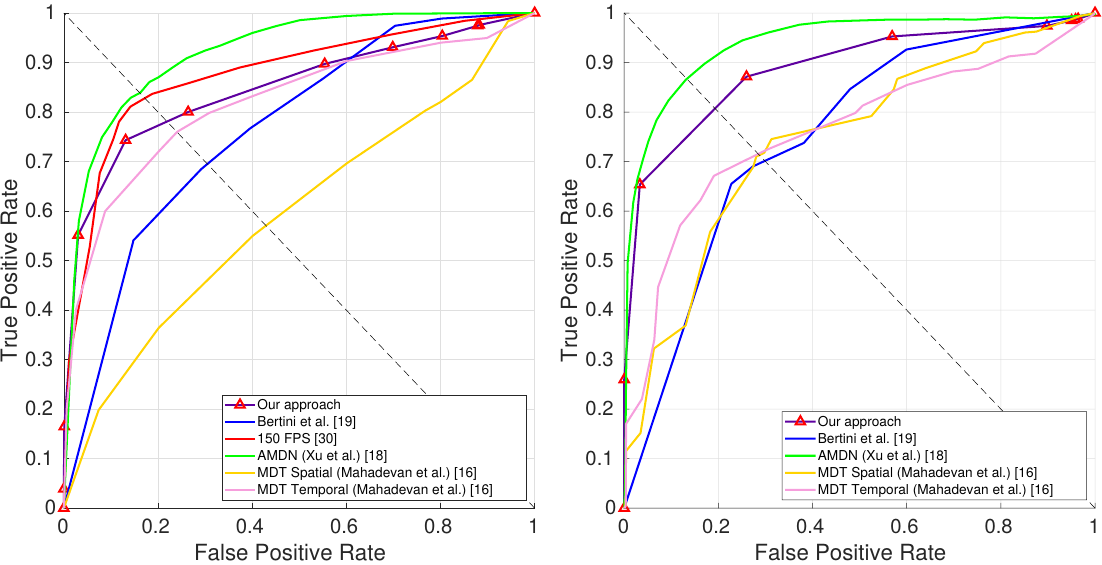
Figure 3. Frame-level TPR–FPR curves comparing our approach with various well-known methods in the Ped1 ( left ) and Ped2 ( right )